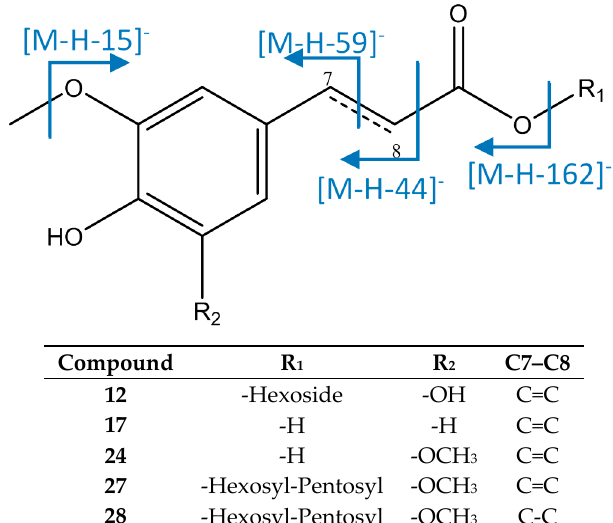
Figure 4. Structure and fragments of acid derivatives (12), (17), (24), (27), and (28).